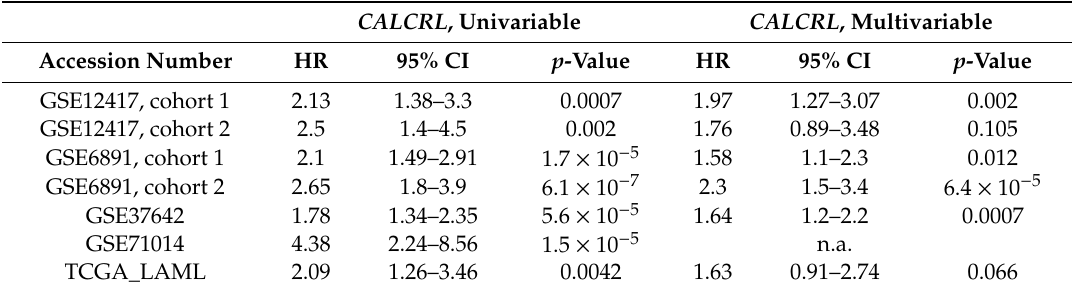
Table 1. Prognostic significance of CALCRL in publicly available AML gene expression data sets. CALCRL , Univariable CALCRL ,